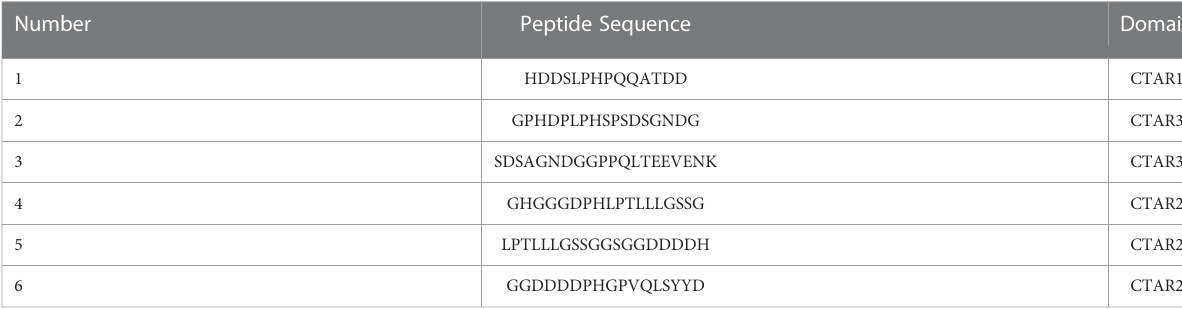
Table 1 Overlapping peptides used for mapping the LMP1-C